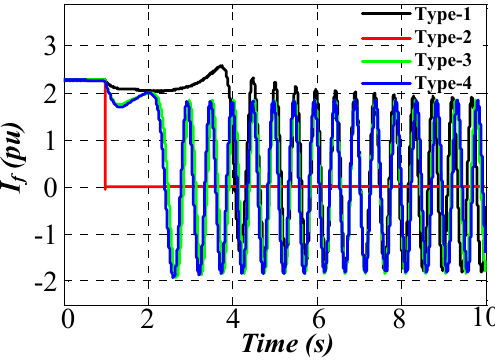
Figure 6. 𝐼 𝑓 Variations during CLOE events in generator heavy loading.